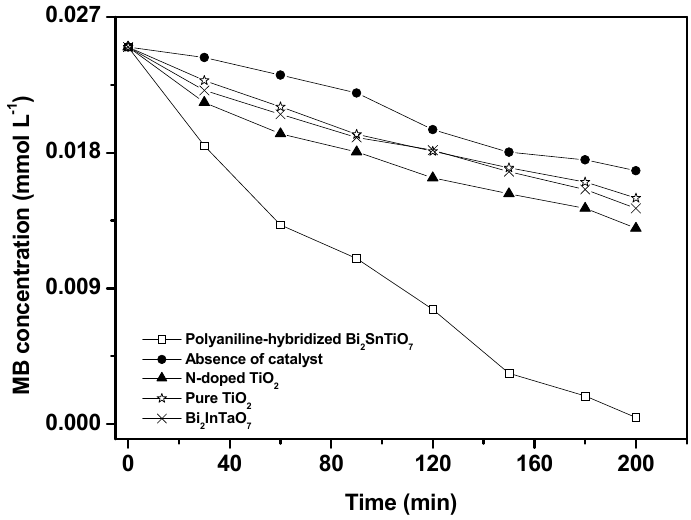
Figure 3. Photocatalytic degradation of methylene blue under visible light irradiation in the presence of the polyaniline-hybridized Bi TiO as well as in the absence of a 2